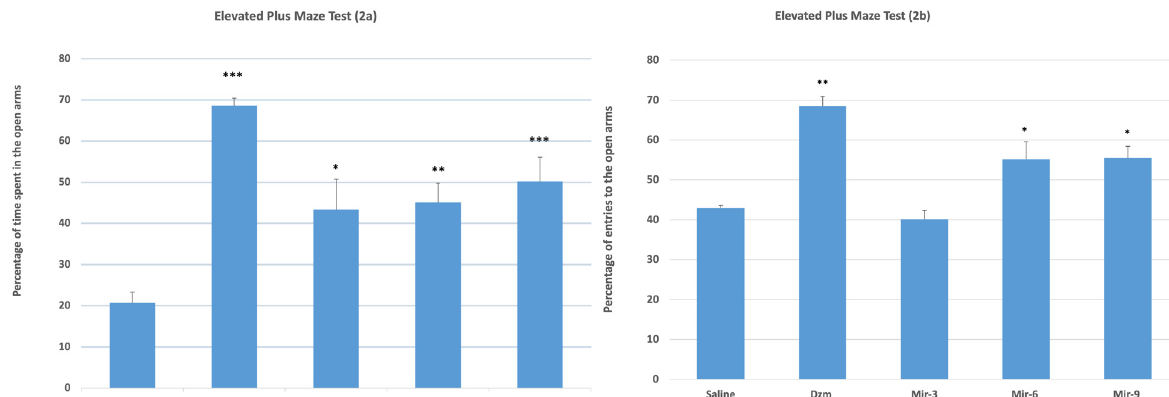
Figure 2. Percentage of time spent in the open arms (2a) and percentage of number of entries to the open arms (2b) in elevated plus-maze test. Data were expressed as mean±SEM; (Saline (n=8); (Dzm 2 mg/kg (n=10); Mir 3 mg/kg (n=7); Mir 6 mg/kg (n=8); Mir 9 mg/kg (n=8). *: p <0.05; **: p <0.01; ***: p <0.001 compared to Saline group, by ANOVA (Tukey